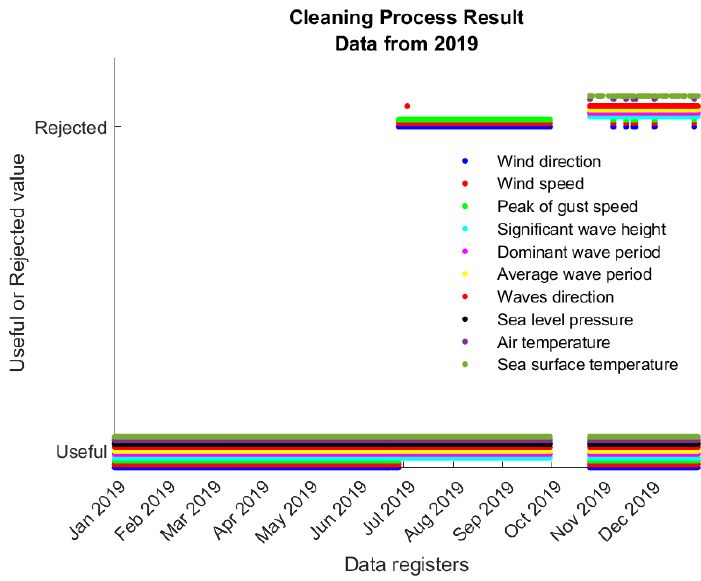
Figure 4. Automatic data cleaning of metocean variables (year 2019).